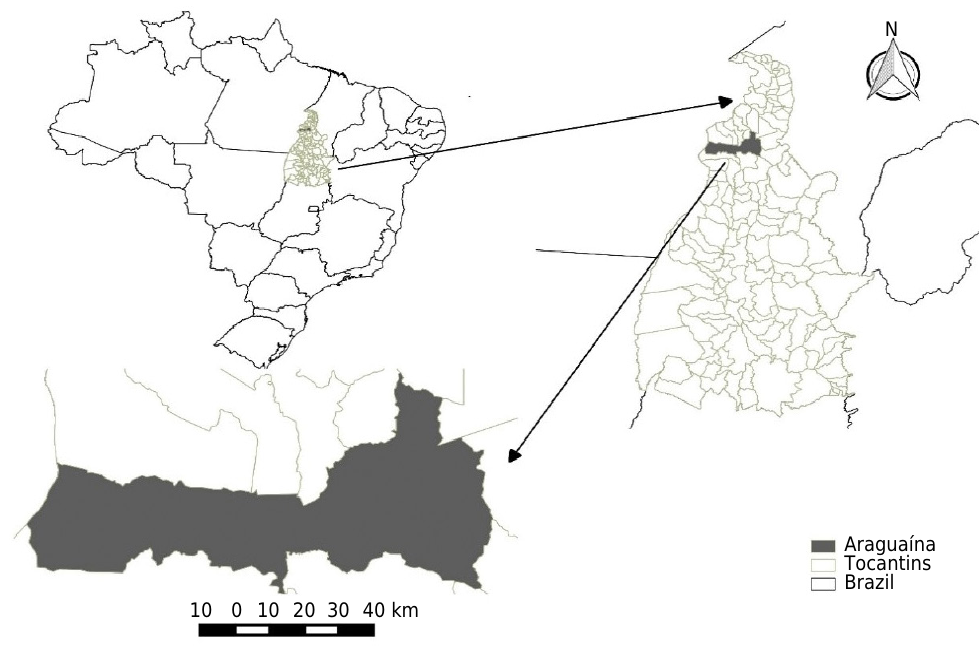
Figure 1. Location of the study area.